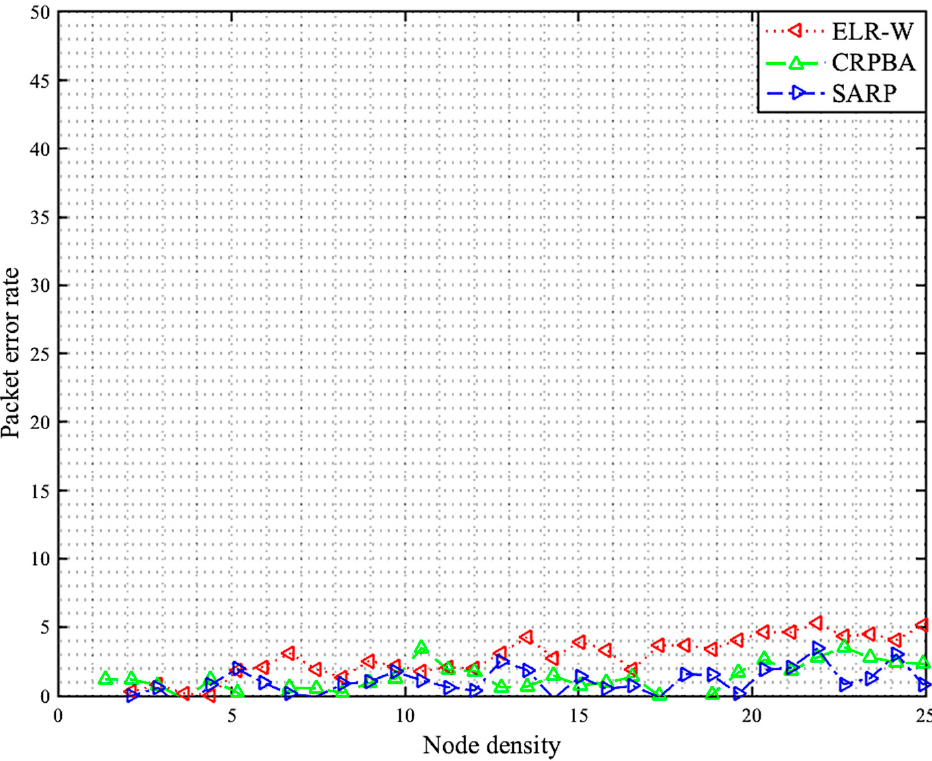
Figure 4. Packet error rate vs node density.